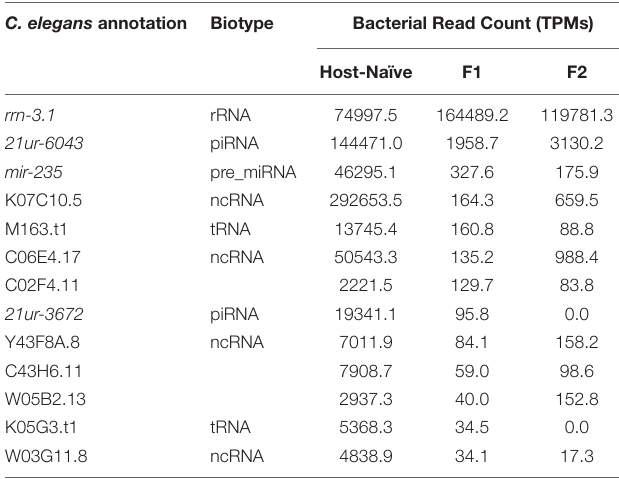
TABLE 1 | Non-coding C. elegans genes matching bacterial reads with high expression in host-naïve and intestinal